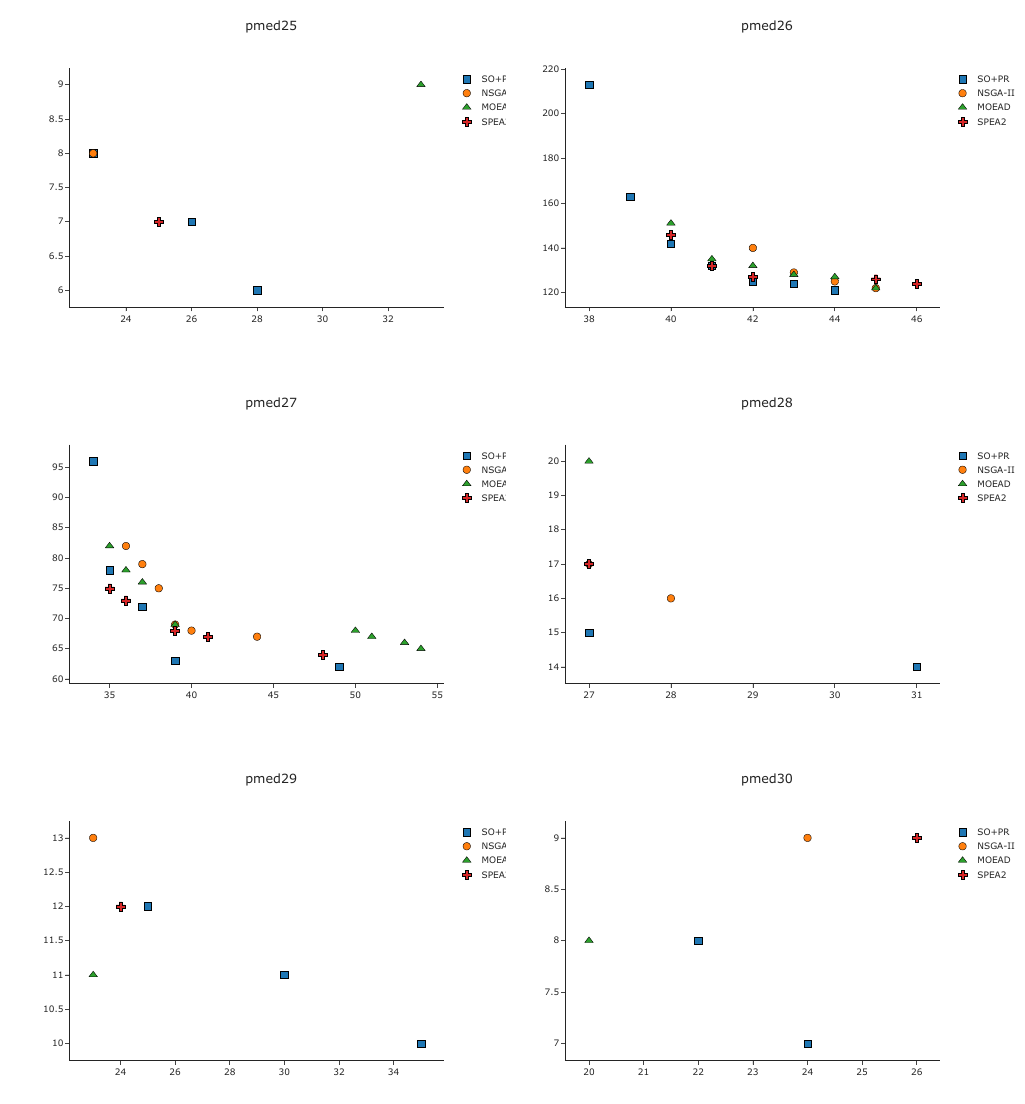
Figure A3. Efficient sets of solutions for SO+PR , MOEAD , NSGA-II , and SPEA2 for instances pmed21 to pmed30.